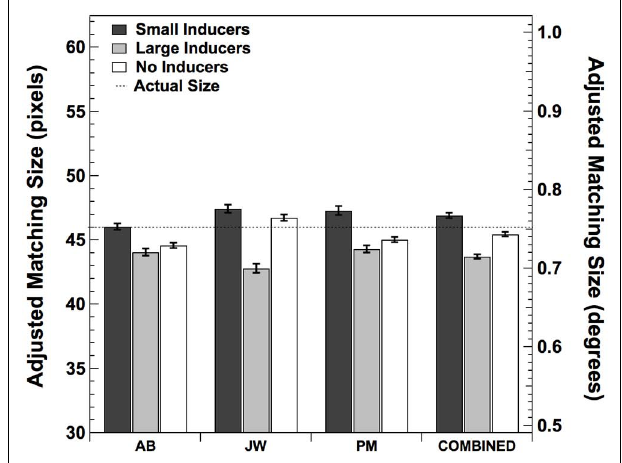
FIGURE 2 | Mean adjusted size matches in each condition from Experiment 1. Error bars correspond to ± 2 standard errors of the mean.